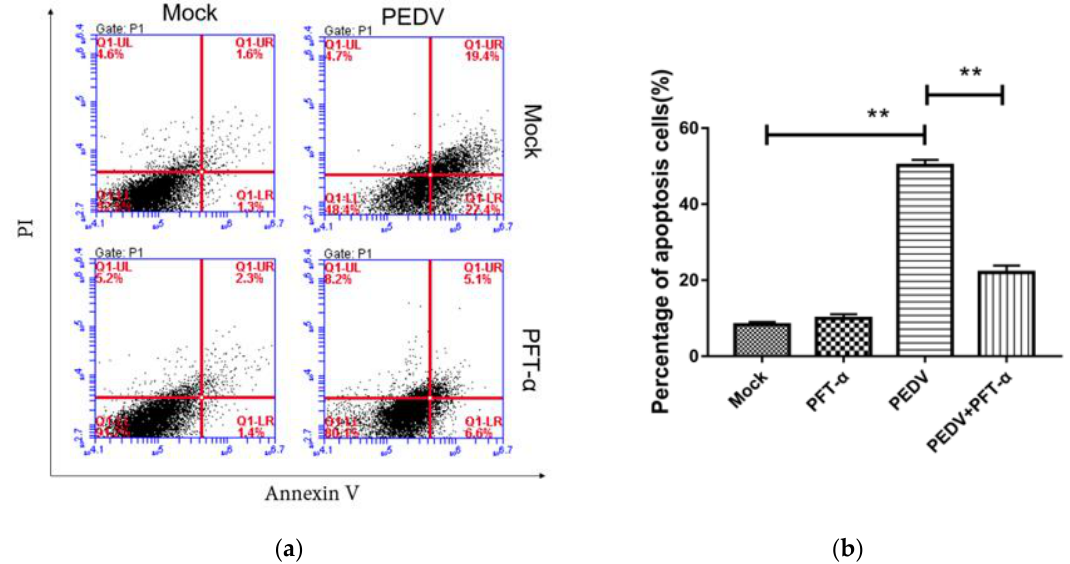
Figure 8. Detection of PFT by MTT- α Inhibition of cell activity ( a ) and percentage of apoptosis cells ( b ). **, p < 0.01.